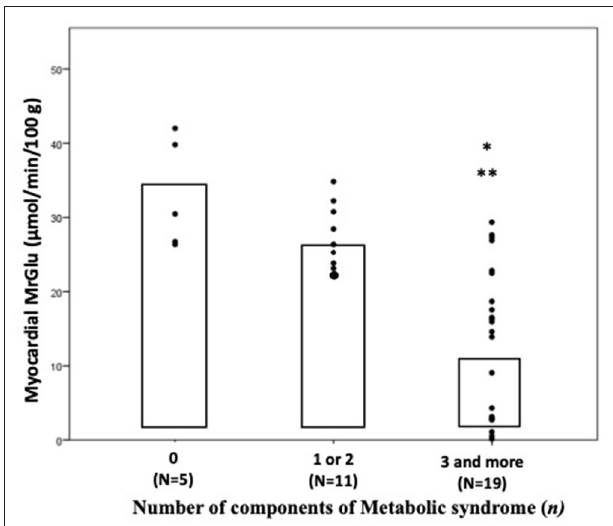
FIGURE 1 | Myocardial glucose metabolic rate in subjects divided by number of components of metabolic syndrome. P -values refer to analyses after adjustment for age and sex. * P < 0.0001 vs. 0 component group; ** P < 0.0001 vs. 1 or 2 components group. MrGlu, glucose metabolic